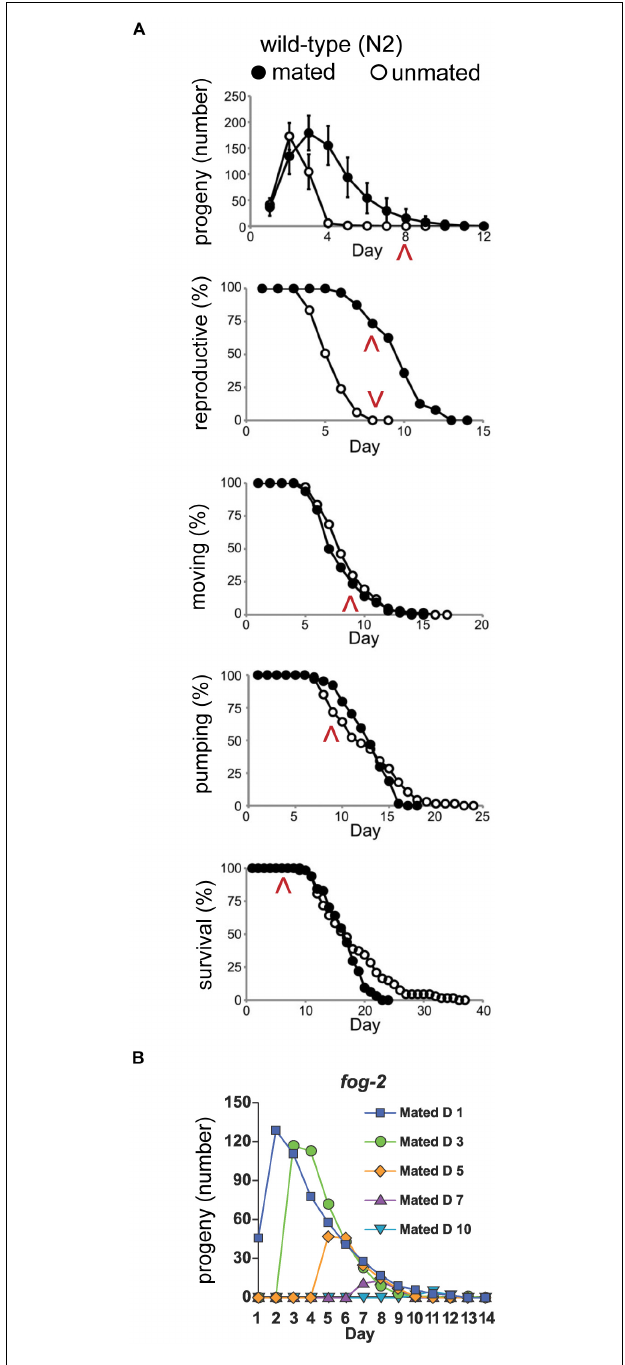
FIGURE 2 | Somatic and reproductive aging are independent of progeny production. (A) Progeny production, reproductive span, body movement span, pharyngeal pumping span, and lifespan of mated and unmated wild-type hermaphrodites. The increase in amount and duration of progeny production caused by male mating does not accelerate somatic aging. Red arrowheads highlight day 8 in each span. Adapted from Pickett et al. (2013). (B) Feminized fog-2(q71) mutants were mated to wild-type males for 24–48 h at different ages. Progeny curves show that late progeny production and reproductive span after peak were independent of early progeny production. Adapted from Hughes et al. (2007).